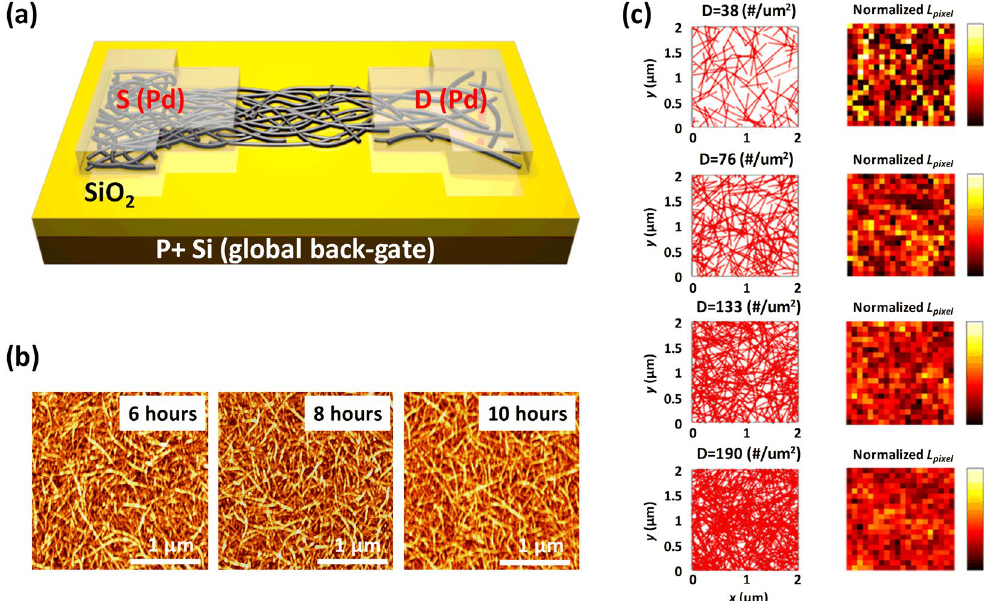
Figure 1. ( a ) Schematic of the CNT-TFT used in this work. ( b ) AFM image (2.5 × 2.5 µ m, z-scale is 10 nm) of the CNT network channel constructed from a 99% semiconducting CNT solution with deposition times of 6, 8, and 10 h. ( c ) Simulation results of the randomly generated CNT network with different CNT densities (left) and visualized length ( L pixel ) of CNTs for each 400 pixels normalized by the average value of L pixel from all